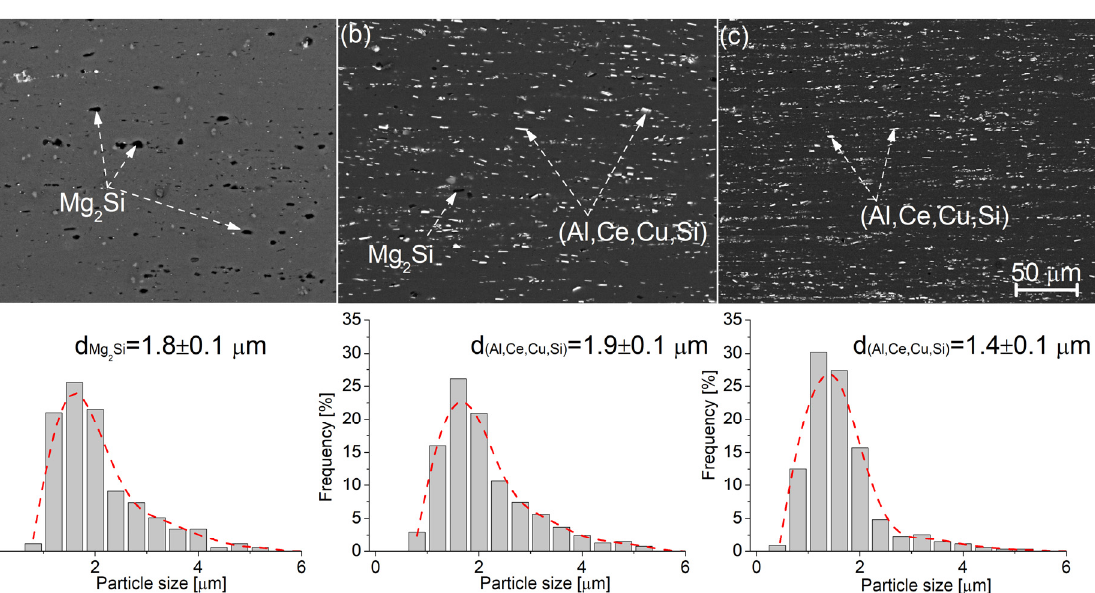
Figure 5. TEM micrographs for the 4C alloy; ( a ) bright field; ( b ) dark field; ( c ) high-resolution image of dispersoid; insert in ( b ) is corresponding SAED and insert in ( c ) is corresponding FFT.